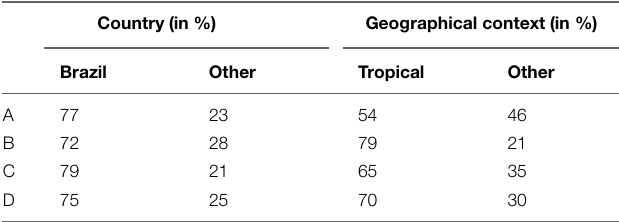
TABLE 4 | When matching the chocolate to a country, between 72 and 79% of the participants chose Brazil. Country (in %) Geographical context (in